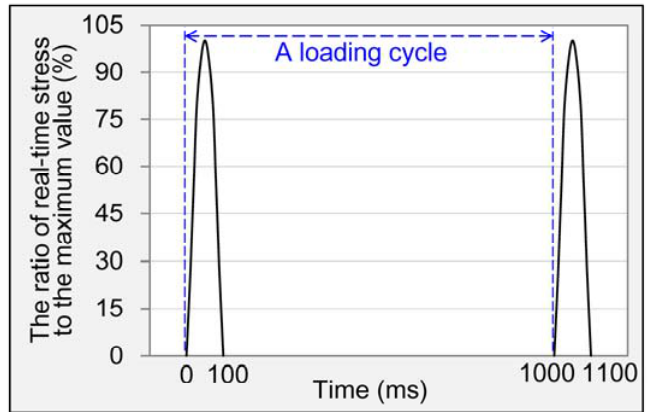
Figure 4. Loading signal used in this research.